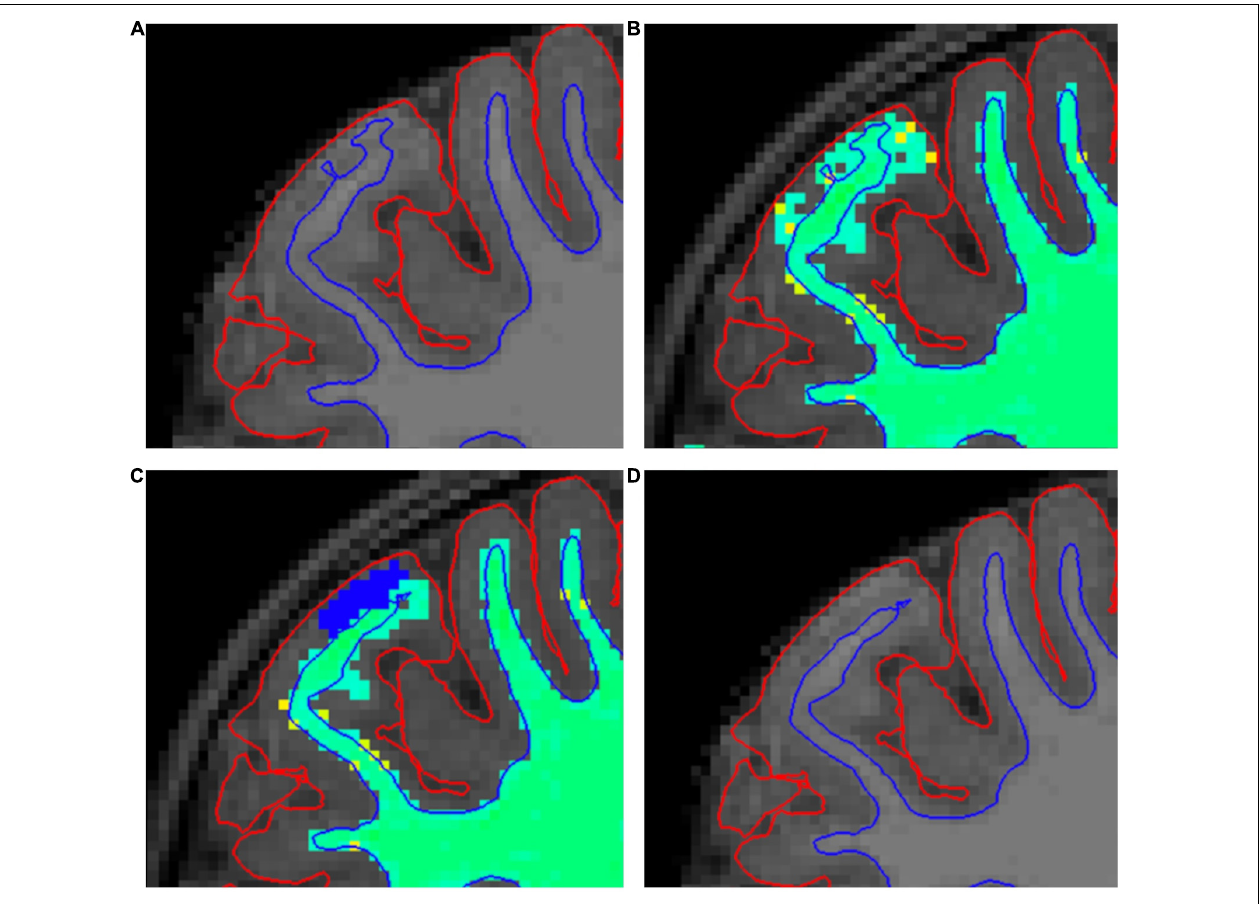
FIGURE 3 | A demonstration of our white matter (WM) mask editing protocol. (A) Shows a typical error in the border between white and gray matter (WM–GM border), where it extends too close to the pial border. Errors such as this are searched for in the “brainmask” volume (A,D) . (B) Shows the same error in “wm” volume with “Jet” colormap (B,C) . (C) Shows how we fixed these errors by erasing the erroneous WM mask (blue voxels). (D) Shows the final result after the second